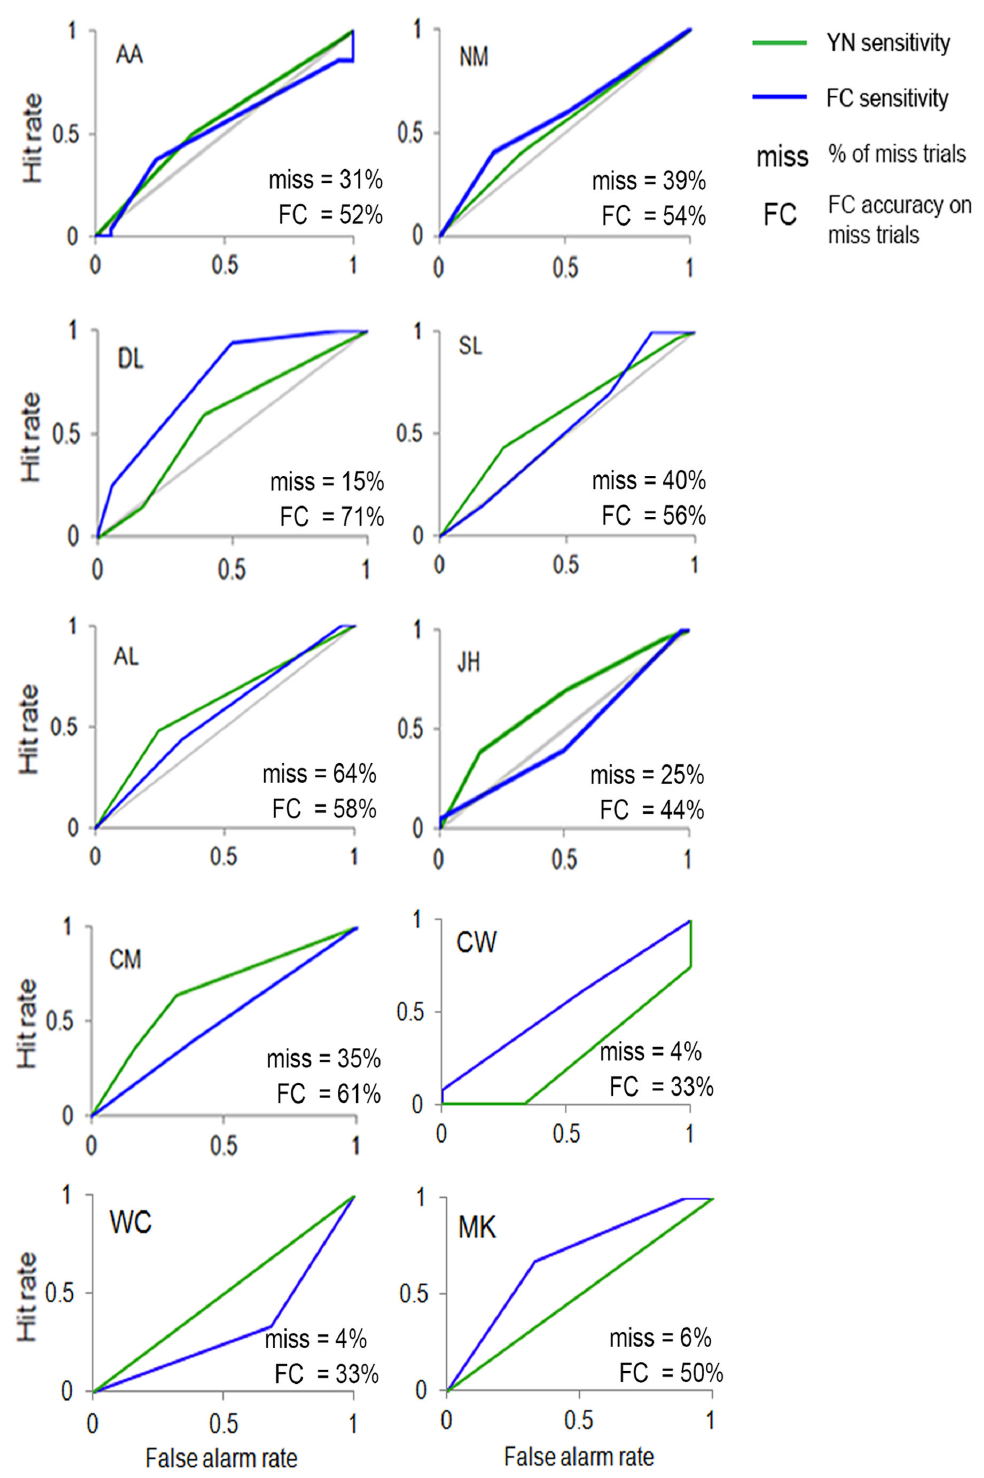
Figure 4. ROC curves. ROCs representing visual sensitivity in the absence of visual awareness after TMS stimulation of Cz. The green lines show ROCs fitted to confidence ratings for “no” responses in the Yes-No task, which refers to when the subject said they did not see the visual stimulus. The ROCs in blue were based on forced-choice judgments that were made after subjects reported “no” to seeing the visual stimulus. doi: 10.1371/journal.pone.0082828.g004 PLOS ONE |